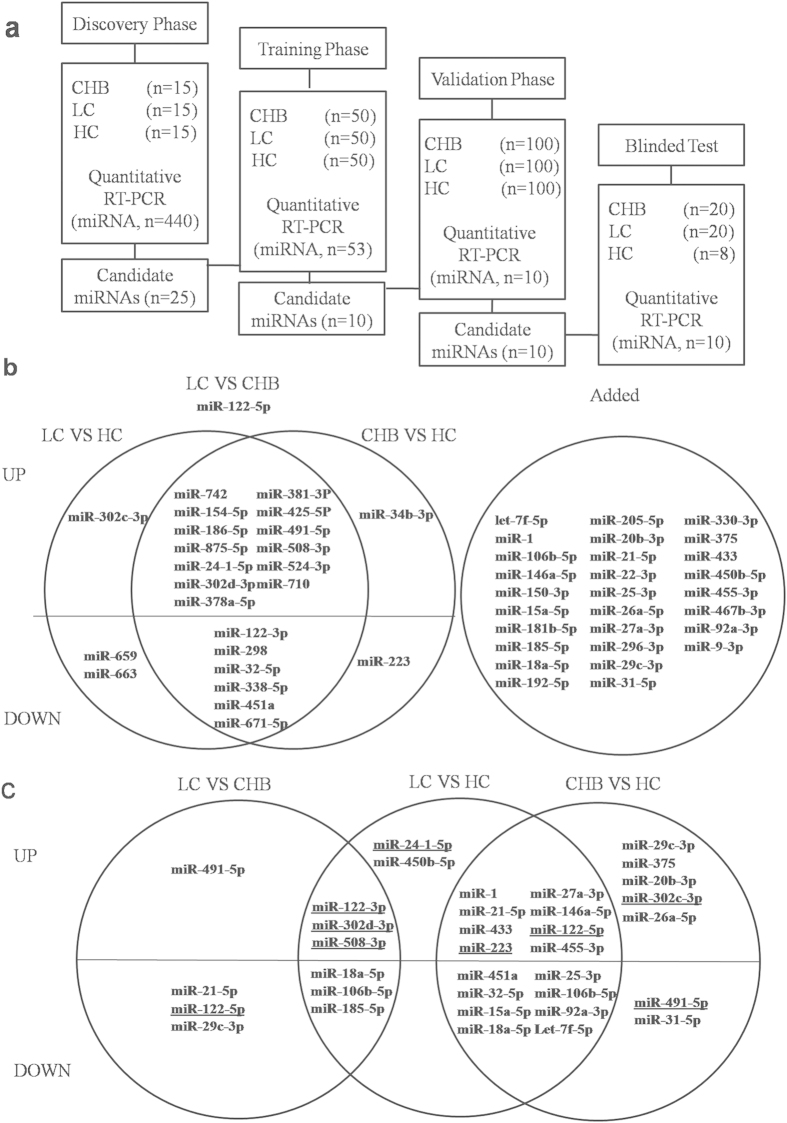
Profiling of miRNAs.(a) Study design, Chronic hepatitis B (CHB) patients, liver cirrhosis (LC) patients and healthy controls (HC) were recruited for the discovery (15/group), training (50/group), validation (100/group) phases, and the blinded test. Individual miRNAs in the plasma were measured using quantitative realtime-PCR assay. (b) Profiling of miRNAs in training phase of HBV infected patients. (c) Profiling of miRNAs in validation phase of HBV infected patients. MiRNAs with significantly different expression levels between CHB, LC and HC of training phase (b) and validation phase (c) were shown. MiRNAs up indicates up-regulation while down meant down-regulation. Lined showed same miRNAs had different expression levels in different groups.